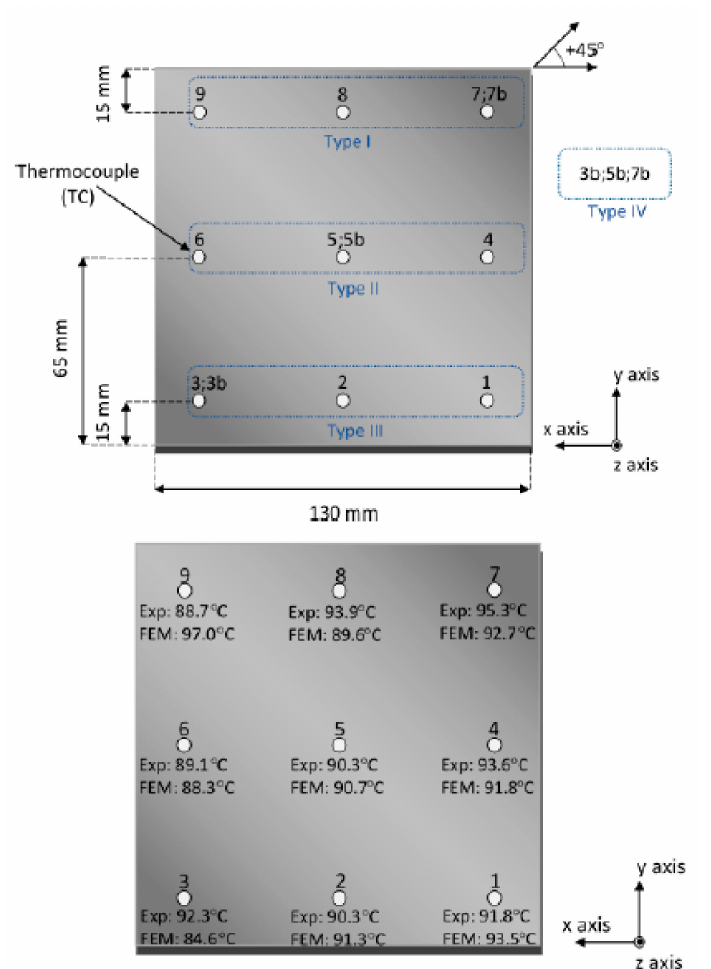
Figure 12. Schematic representation of location of the thermocouples and the experimental–numerical obtained temperature values (reprinted with permission from